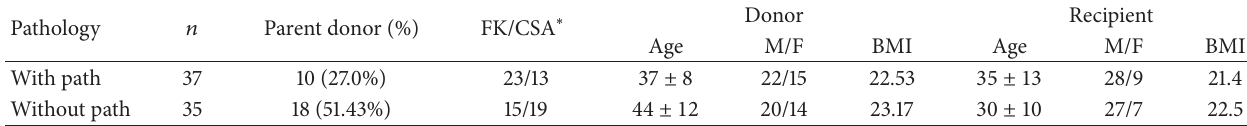
Table 1: Demographic data of donors and recipients.